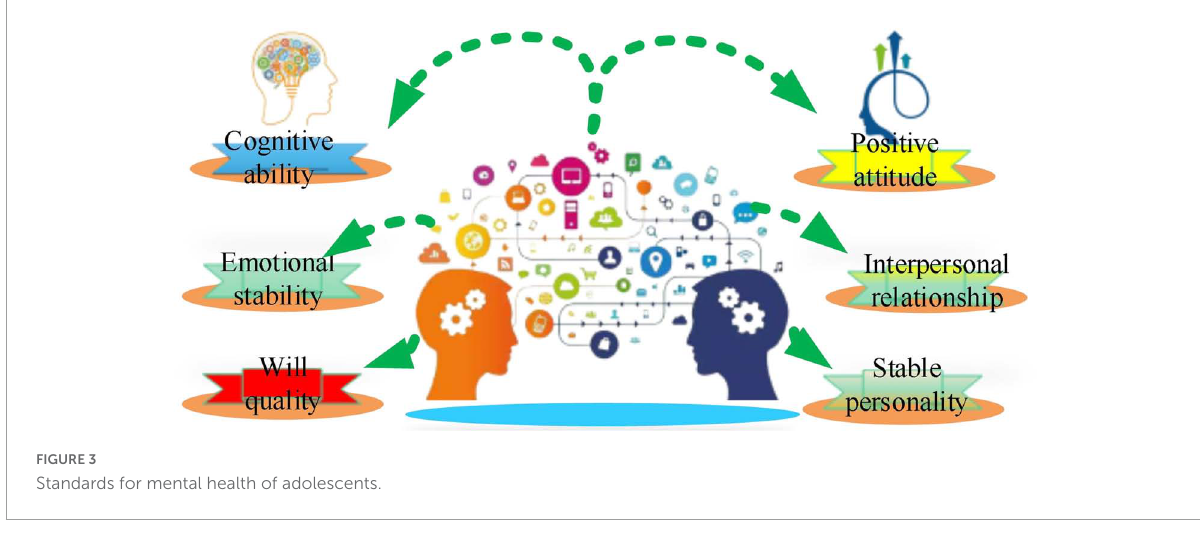
TABLE 1 Factors that affect the mental health of